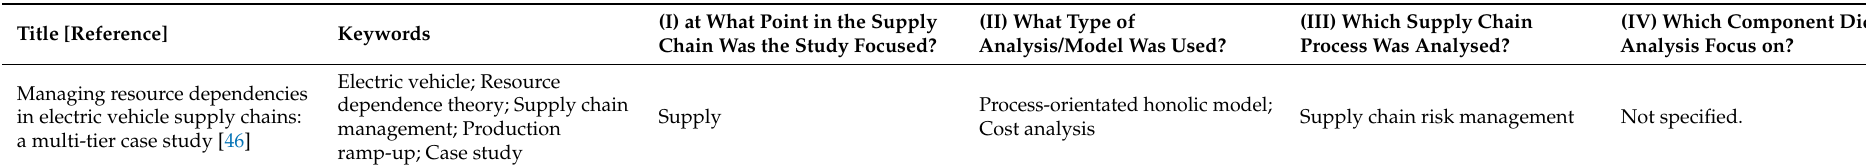
Table A4. PRISMA meta-analysis of documents found related to electric vehicles supply chains.